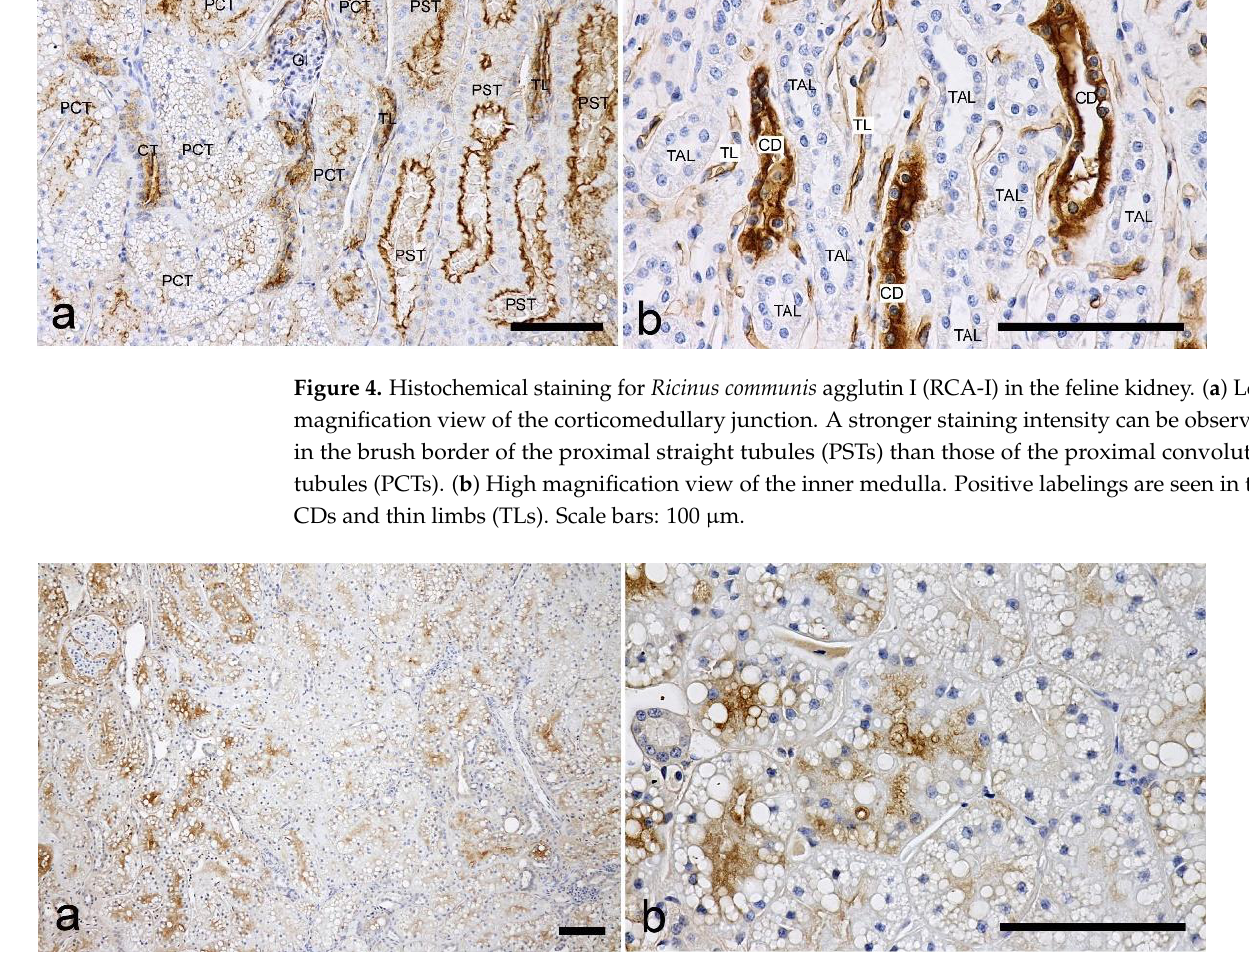
Figure 5. Histochemical staining for concanavalin A (ConA) in the feline kidney. ( a ) Low magnification view of the cortex. ( b ) High magnification view of the cortex. Heterogeneous staining intensities are observed in the proximal convoluted tubules. Scale bars: 100 µ m.